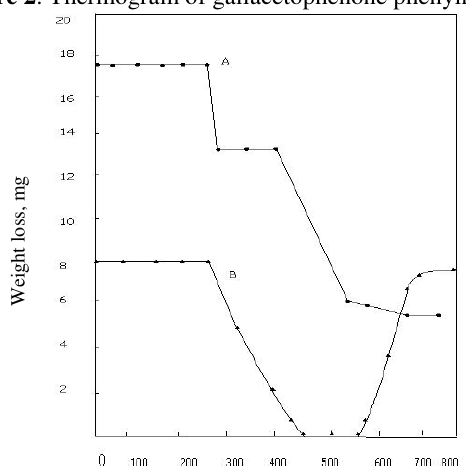
Figure 2 . Thermogram of gallacetophenone phenylhydrazone